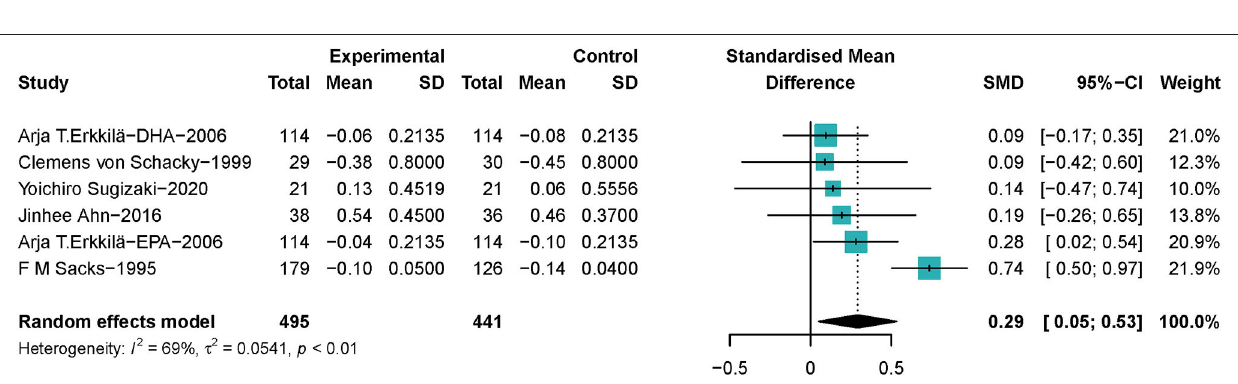
FIGURE 4 | Forest plots of associations of ω -3 PUFAs and most stenotic segment of the coronary artery. Point sizes are an inverse function of the precision of the estimates, and bars correspond to 95% CIs. Data are calculated using a random-effect